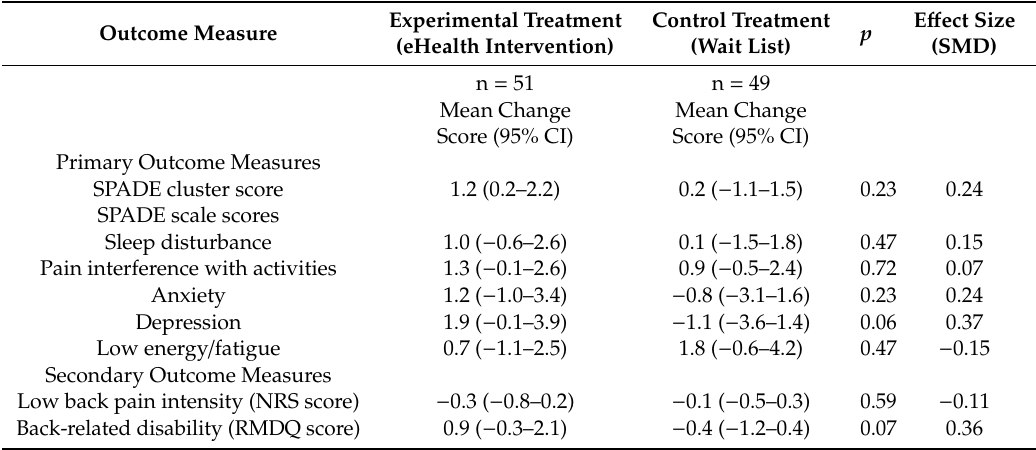
Table 3. Changes in primary and secondary outcome measures over 3 months according to treatment group ( N = 100)